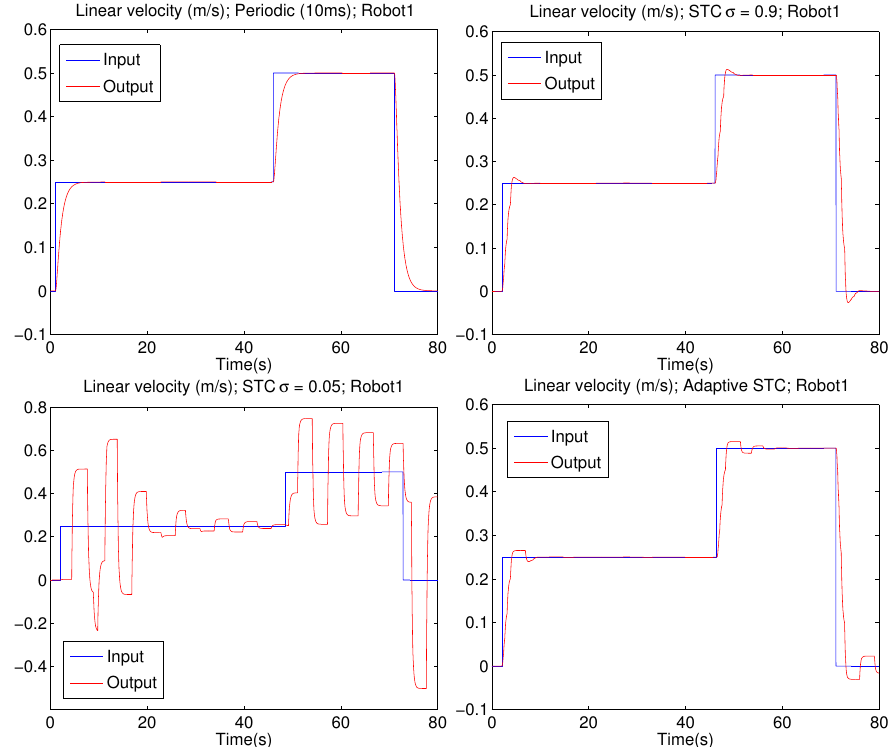
Figure 7. Linear velocity registered (red line) when a reference (blue line) is applied to one of the robots. Results from different implementations: periodic sampling ( Upper Left Corner ), fixed high value of the sigma parameter ( Upper Right Corner ), fixed low value of the sigma parameter ( Lower Left Corner ) and adaptive solution proposed by the authors ( Lower Right Corner